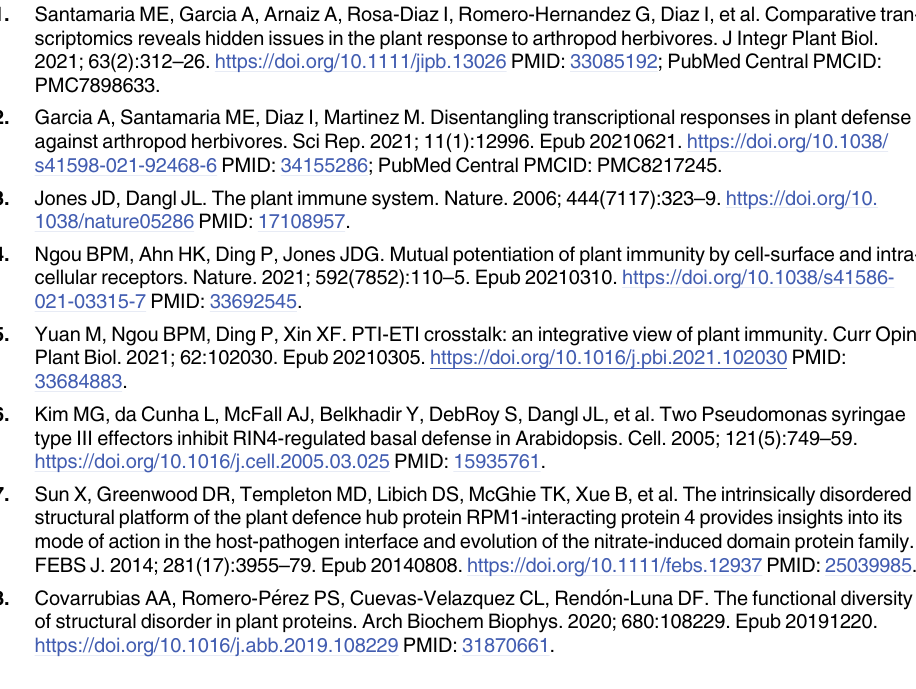
S1 Fig. Phylogenetic trees of short one-NOI RIN4-like/NOI family proteins from monocot species and PAS species. Bootstrap is shown in each